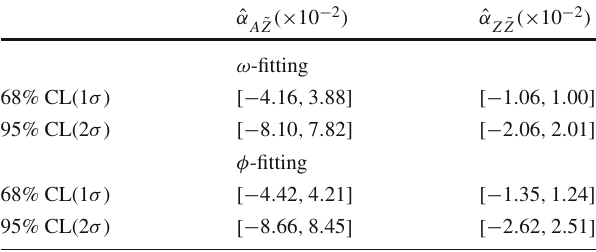
Table 2 Summary of 1 σ and 2 σ bounds on ˆ α analyses by fitting to φ and fitting to ω through μ + μ − H process which is shown in Sects. 5.1 and 5.2.